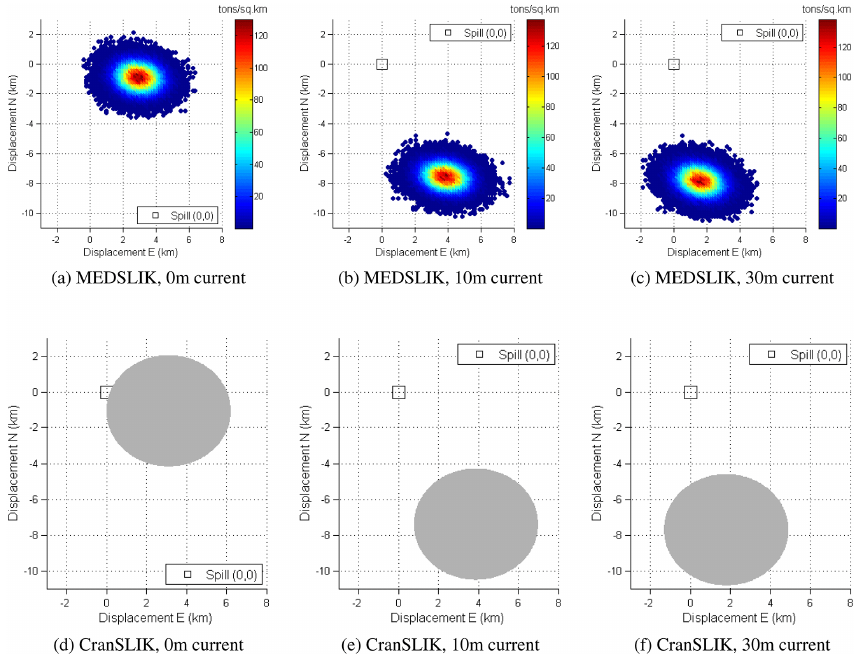
Figure 5. MEDSLIK and CranSLIK forecasts of slick after 36h for the Algeria point case, using the current at different depths as the advective